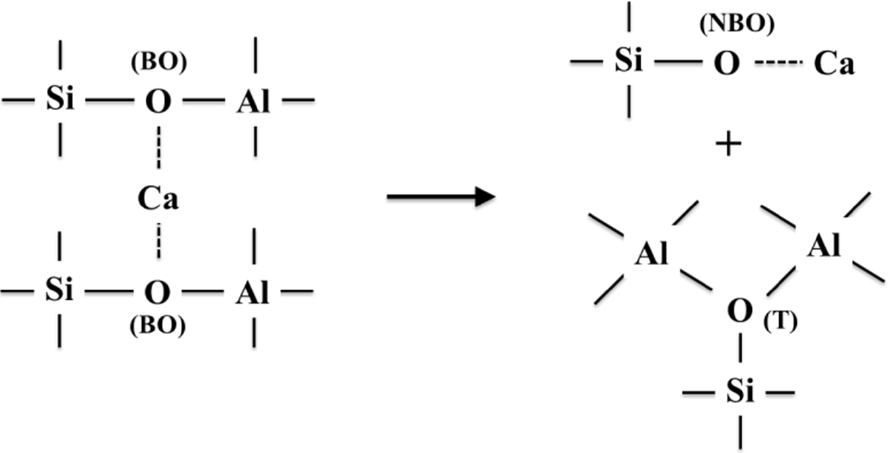
Figure 5. Cartoon of transformation of bridging oxygen (BO) to non-bridging oxygen (NBO) of aluminosilicate.